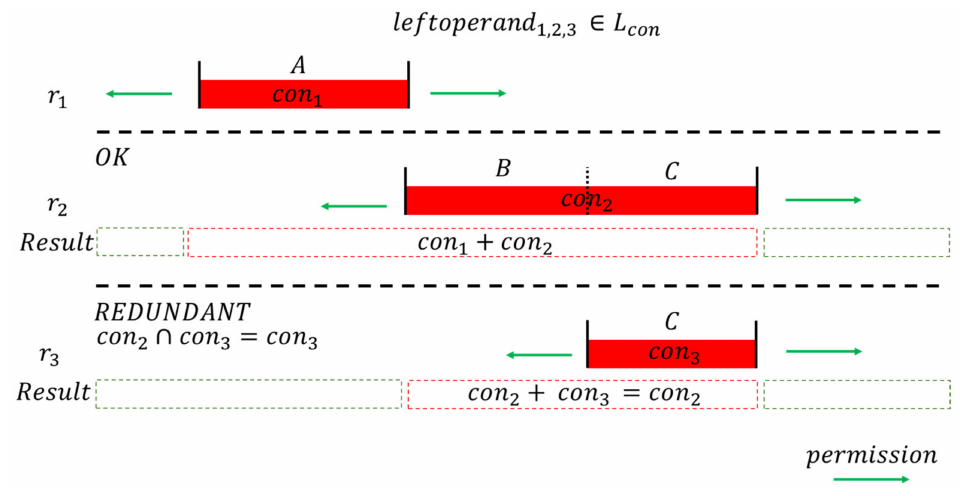
Figure 4. Common Resource Conflict Detection. Blacklisting